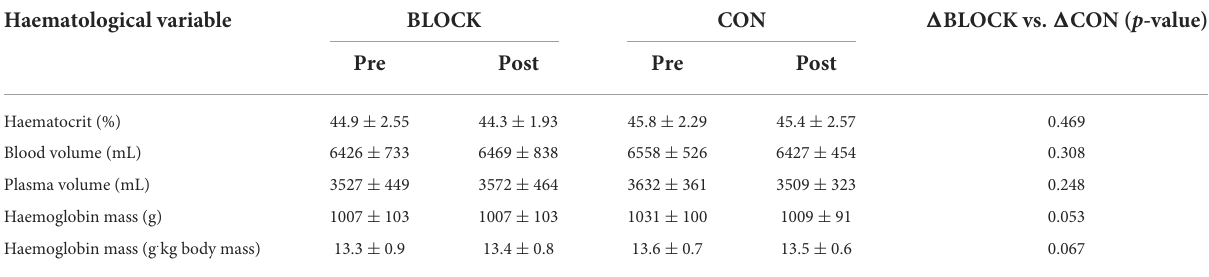
TABLE 2 Haematological variables before (pre) and after (post) the intervention for the HIT block group (BLOCK) and the control group (CON). Haematological